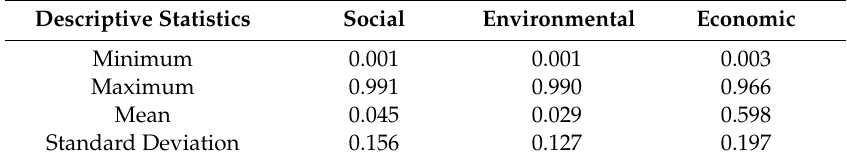
Table 7. Statistical information for weights